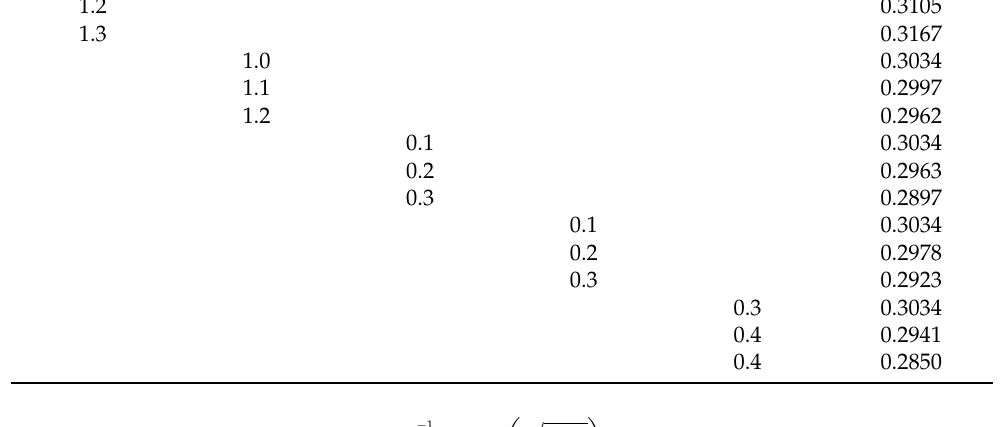
Table 5. Various numerical results for Re